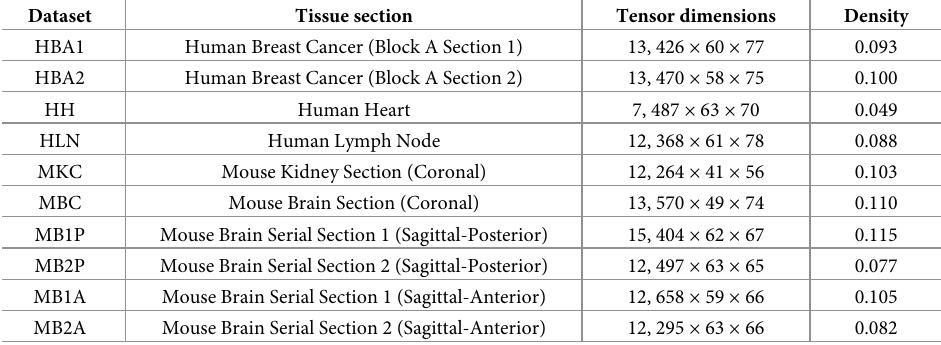
Table 2. 10x Genomics spatial transcriptome data from 10 tissue sections. Dataset Tissue